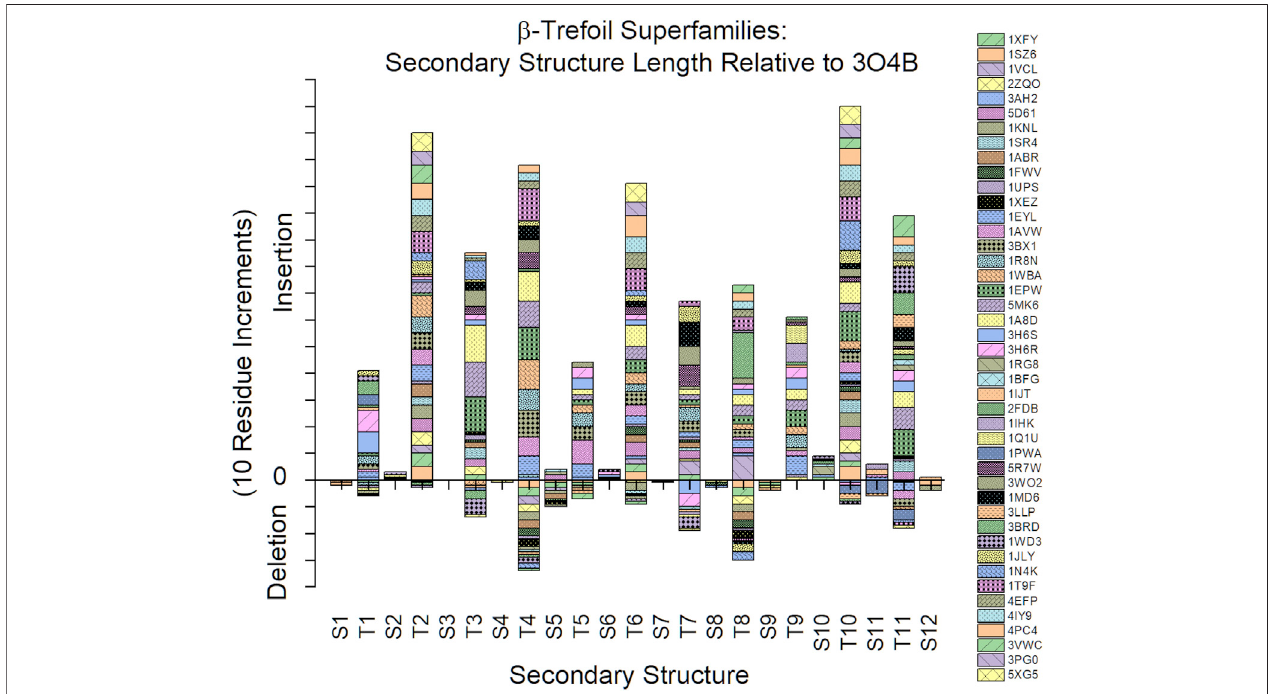
FIGURE 3 | Relative insertions or deletions in secondary structure elements among the β -trefoil superfamily of proteins. The reference protein is the Symfoil protein — a de novo designed, purely-symmetric, minimalist, and functionless β -trefoil protein (see text).